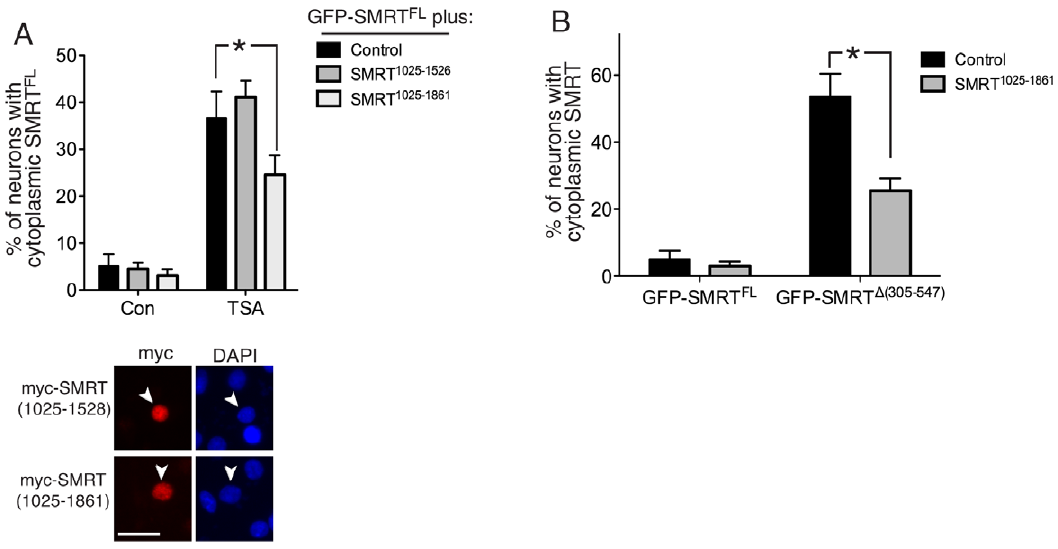
Figure 4. Over-expression of the RD4 region of SMRT inhibits HDAC inhibition-mediated SMRT export. A) Upper: Over-expression of RD4 inhibits TSA-mediated nuclear export of SMRT. Neurons were transfected with GFP-SMRT FL plus an expression vector encoding the amino-acids 1025–1526 (RD3) or 1025–1861 (RD3–4) of SMRT or a control plasmid (encoding ß-globin). After 48 h neurons were treated with TSA and the subcellular localization of GFP-SMRT FL was analyzed. * p , 0.05 (n=4). Lower: Example pictures to illustrate the nuclear localization of SMRT 1025–1526 and SMRT 1025–1861 . Neurons were transfected with plasmids encoding myc-tagged SMRT 1025–1526 or SMRT 1025–1861 . After 48 h the localization of these portions of SMRT was analysed by immunofluorescence using an anti-myc antibody. Arrows point to a transfected cell in each case. B) Over- expression of the RD4 region partially reverses the cytoplasmic redistribution of SMRT caused by deletion of the DAD. Neurons were co-transfected with GFP-SMRT FL or SMRT D (305–547) with an expression vector encoding the amino acids 1025–1861 of SMRT or a control plasmid (encoding ß-globin) as indicated. After 48 h the cellular localization of SMRT and SMRT D (305–547) was analyzed. * p , 0.05 (n=3).